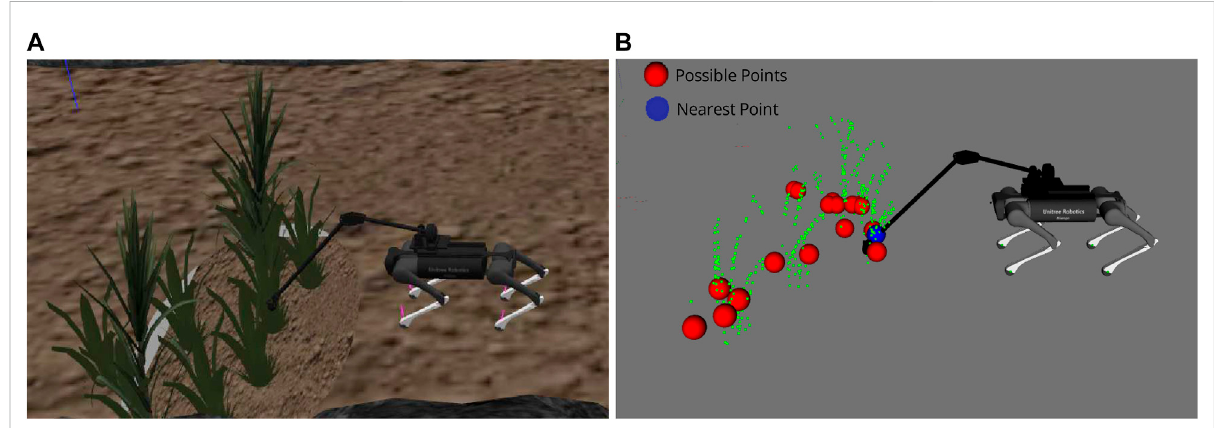
FIGURE 4 Probing planner. (A) Gazebo simulation while probing. (B) Visualization of segmented plants as green points, possible ground probing points as red, and probing nearest point as